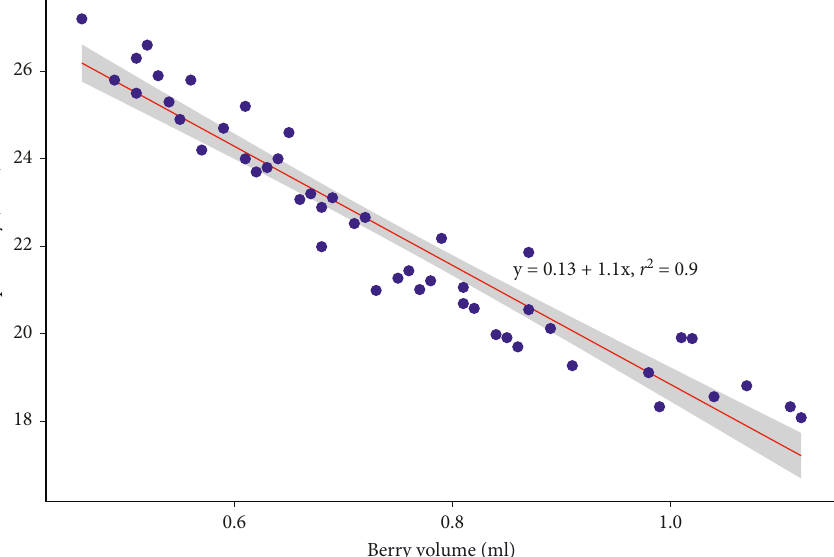
Figure 5: Correlation between grapevine berry volume and TSS